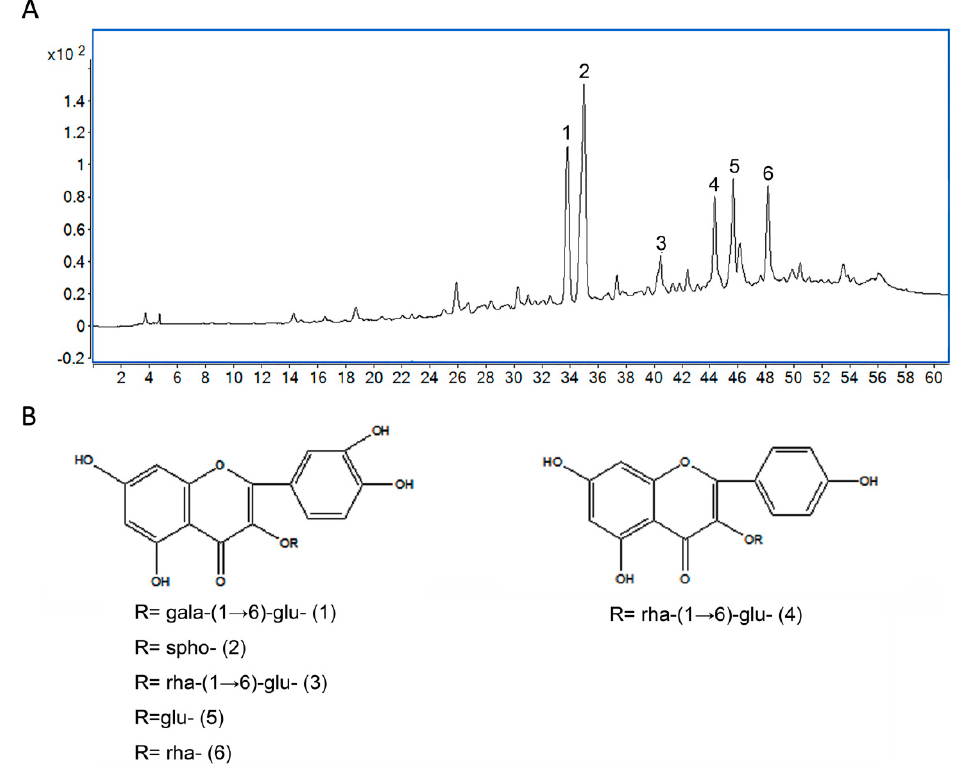
Figure 1. The chromatogram of total flavonoids (TF) analysis by HPLC-QTOF/MS ( A ) and the chemical structures of the six main flavonoids in TF ( B ).